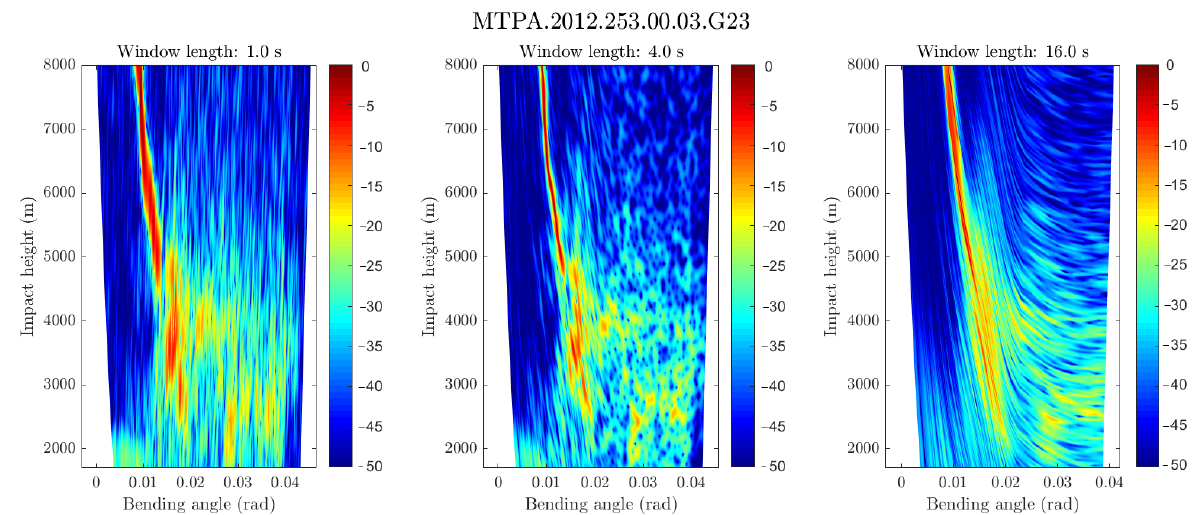
Figure 2. Occultation event from UTC 0003 2012-09-11, 20.16 ◦ S, 114.93 ◦ E. By applying e.g., Hanning windows of various lengths we can observe how the mapped coordinates are arranged. Smeared features along the frequency axis (left) or along the time axis (right) are instead smeared along the band around the range model, or along the range model itself. The center panel shows an appropriate window length for this